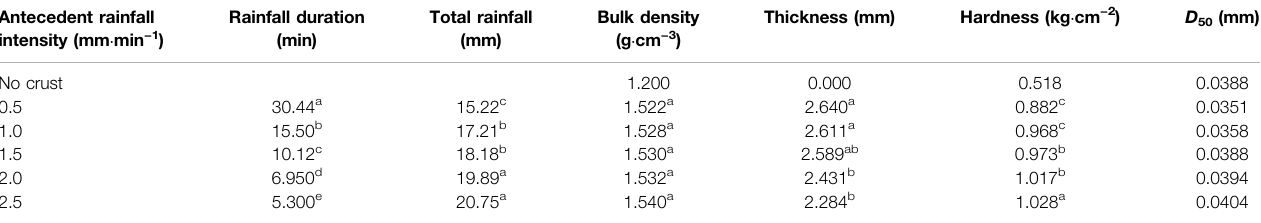
TABLE 1 | Characteristics of antecedent crusts.